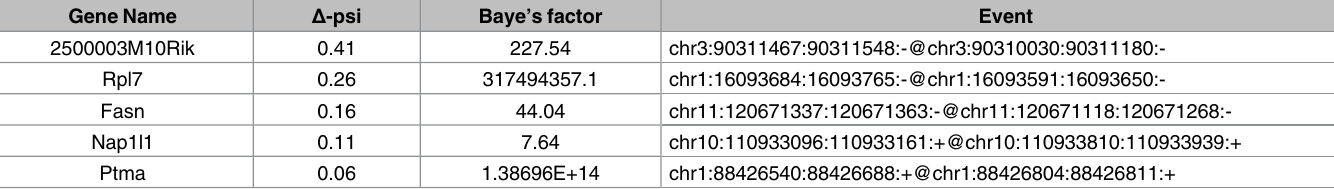
Table 3. SMN-dependent intron skipping events ranked by percent